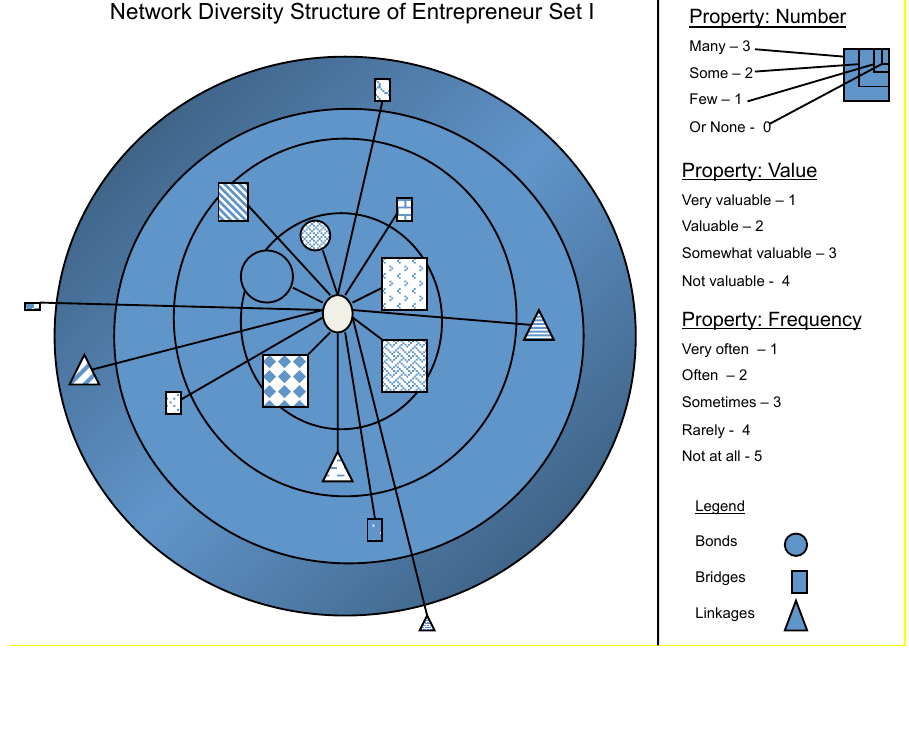
Network Diversity Structure of Entrepreneurship Set